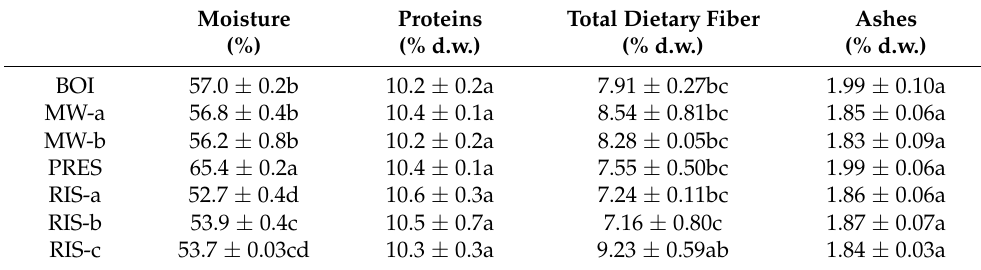
Table 3. Proximate composition of cooked Artemide rice; the results are expressed as mean ± standard deviation. Values with different letters in the same column are significantly different ( p <